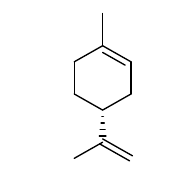
Figure 6. ( R )- (−) -Carvone thiosemicarbazone 14 (L 1 ) and Pd(II) complex 15 (PdL 1 Cl 2 ). Figure 6. ( R )-( − )-Carvone thiosemicarbazone 14 (L 1 ) and Pd(II) complex 15 (PdL 1 Cl